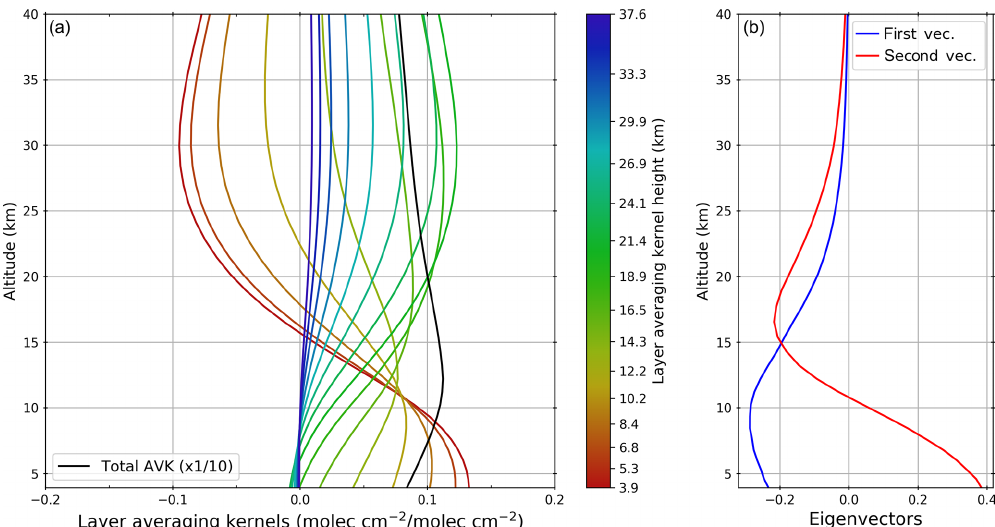
Figure 2. Mean layer averaging kernels (a) normalized for partial columns (moleccm − 2 /moleccm − 2 ) and eigenvectors (b) characterizing the FTIR retrievals of HCFC-22 above Jungfraujoch from spectra recorded in 2015 by the Bruker instrument. The ticks on the colour bar are the individual layer averaging kernels represented in the plot. The first eigenvector has a value of 1 for both instruments, and the second eigenvector has a value of 0.68 and 0.85 for the homemade and Bruker instruments, respectively. Table 1. Mean relative errors (%) for both instruments (homemade and Bruker) affecting the total column retrievals of HCFC-22 for the years 1992 (homemade instrument) and 2015 (Bruker). See notes and text (Sect. 3.3) for more information on the values assumed and the